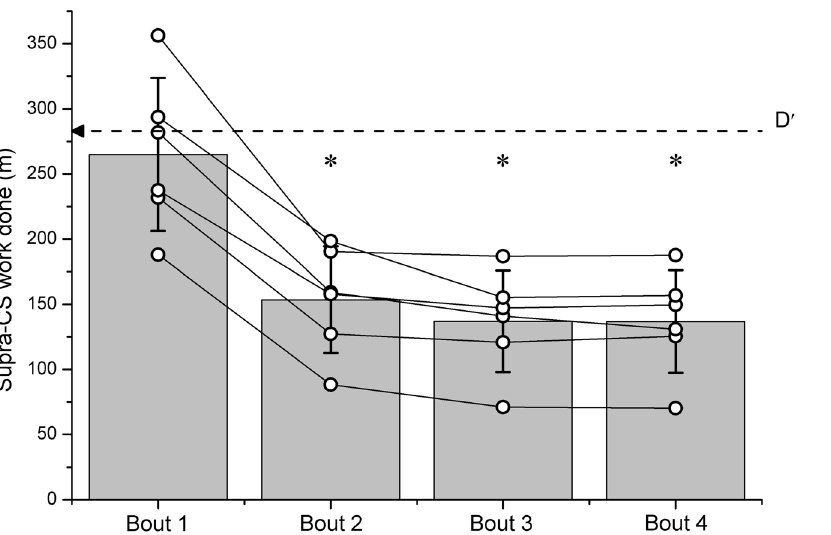
Figure 5. The quantity (with units of meters, m) of supra-CS work (i.e. D 9 ) performed during the maximal HIIT protocol. Bars represent the group mean ( 6 SD), with # representing the individual data. In bout 1, the amount of supra-CS work performed is indistinguishable from D 9 determined from the Speed-tolerable duration relationship. However, in bouts 2, 3 and 4 significantly less supra-CS work is performed ( , 50%) with this significantly less than D 9 (P , 0.050, w ).